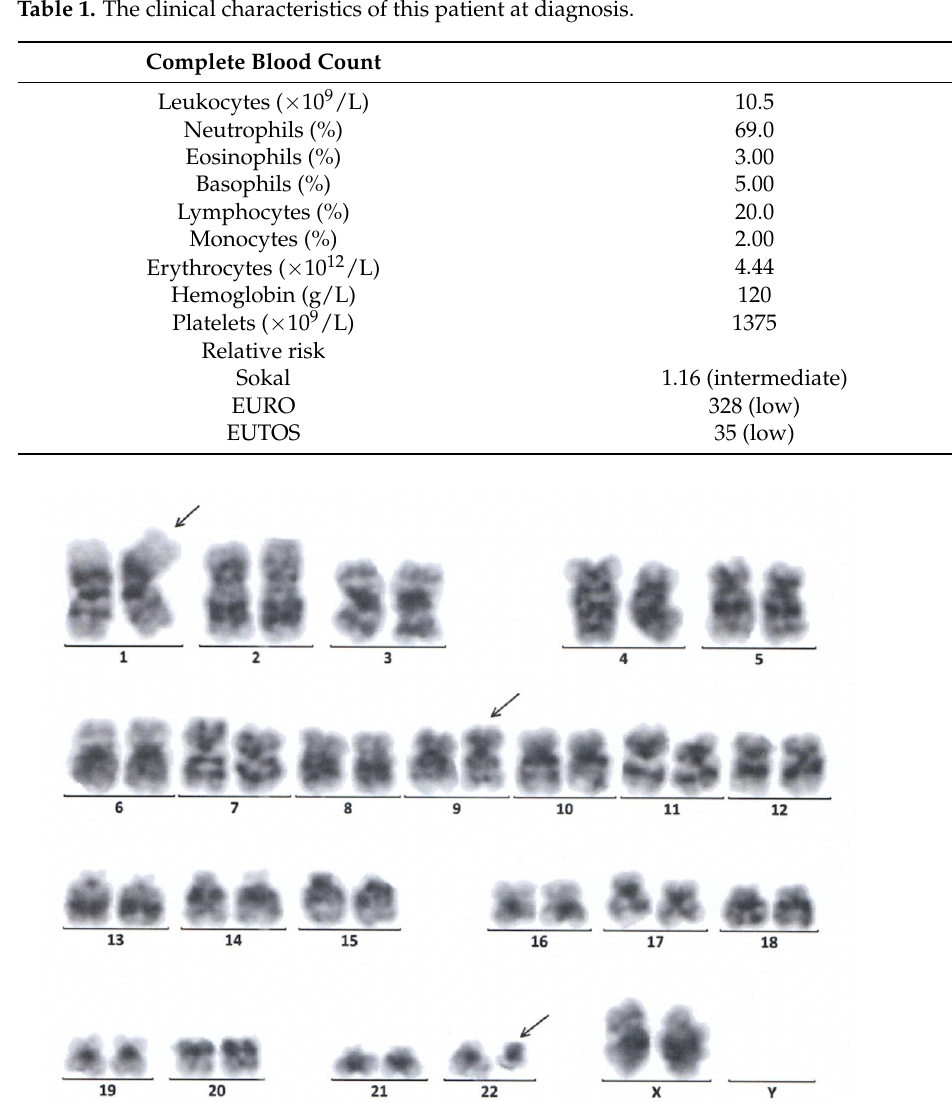
Figure 1. The G ‐ banded karyotype indicated the t (1; 9; 22) (p36.3; q34; q11) translocation. Figure 1. The G-banded karyotype indicated the t (1; 9; 22) (p36.3; q34; q11)